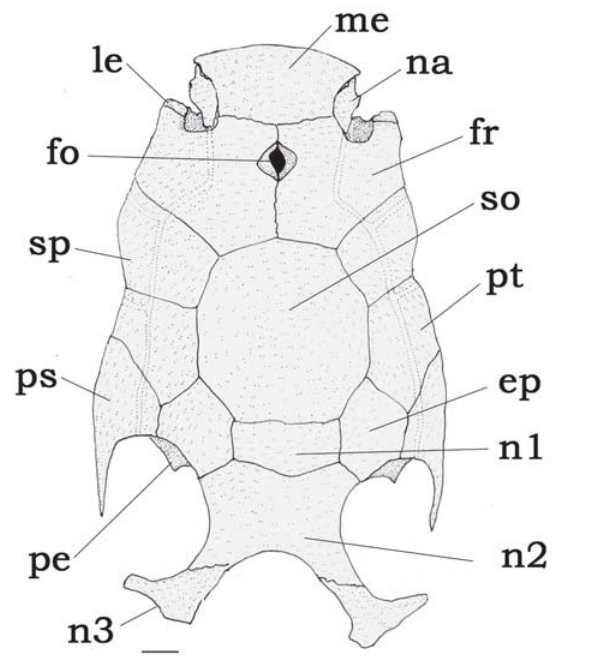
Fig. 8. Neurocranium of Tatia aulopygia , INPA 11080, 80.0 mm SL. Dorsal view. Abbreviations: ep , epioccipital; fo , single cranial fontanel, fr , frontal; le , lateral ethmoid; me , mesethmoid; na , nasal; n1 , first nuchal plate, n2 ; second nuchal plate; n3 , third nuchal plate; pe , posterior epioccipital process; ps , posttemporal-supracleithrum; pt , pterotic; so , supraoccipital; sp , sphenotic. Scale bar = 1.0